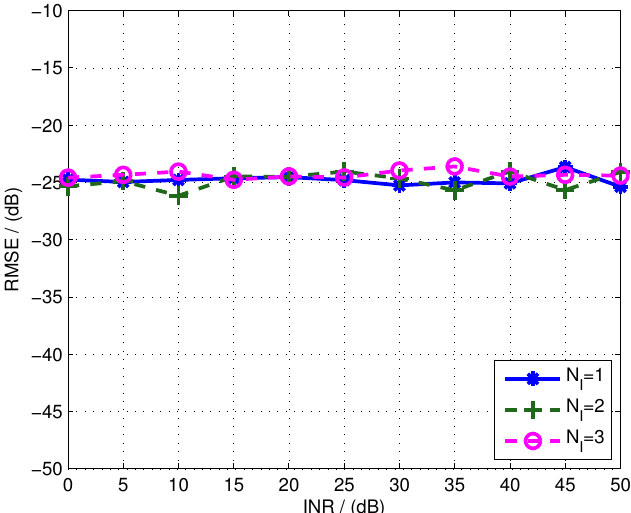
Figure 6. DOA estimation accuracy results obtained by the SSC-MVDR algorithm when there are multiple interfering sound sources with the source intensity gradually increased from 0 dB to 50